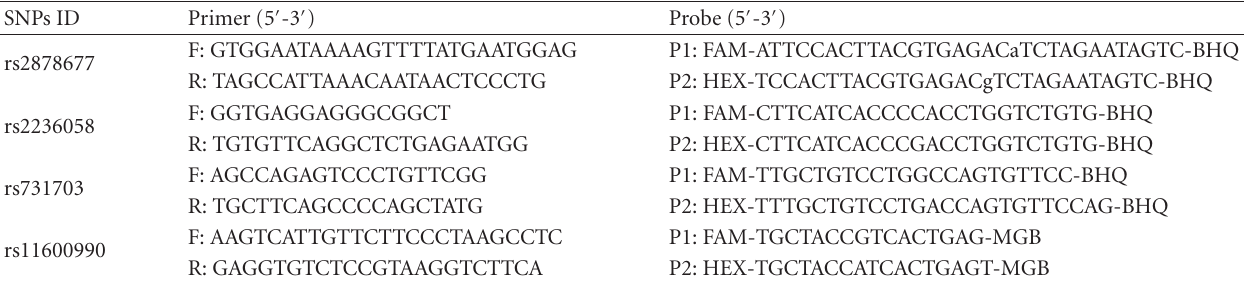
Table 2: Primers and probes of all